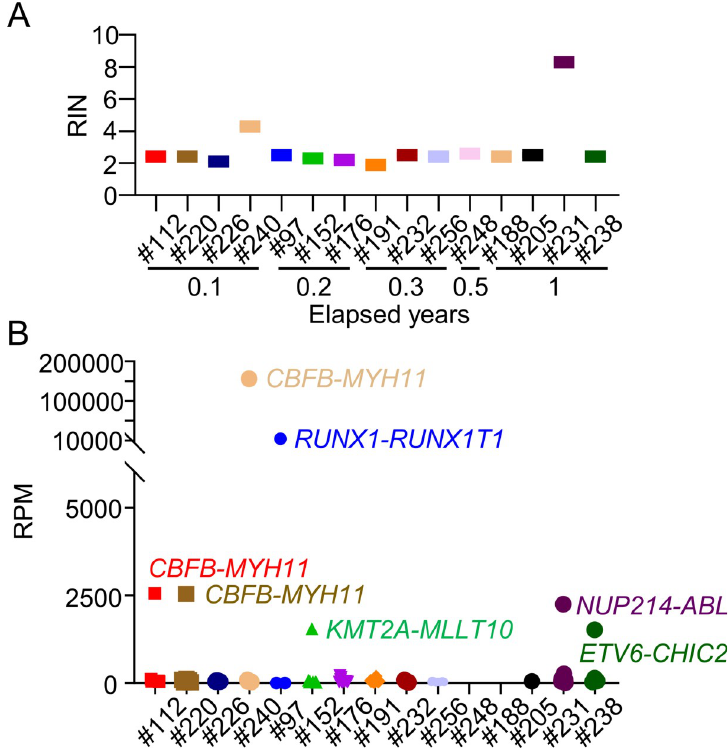
Fig 9. Quality of smear-derived RNA and expression of fusion genes detected by targeted RNA sequencing. (A) RIN value of each sample and elapsed years. (B) Reads per million mapped reads (RPM) of each sample were plotted. Highly expressed fusion genes are shown.